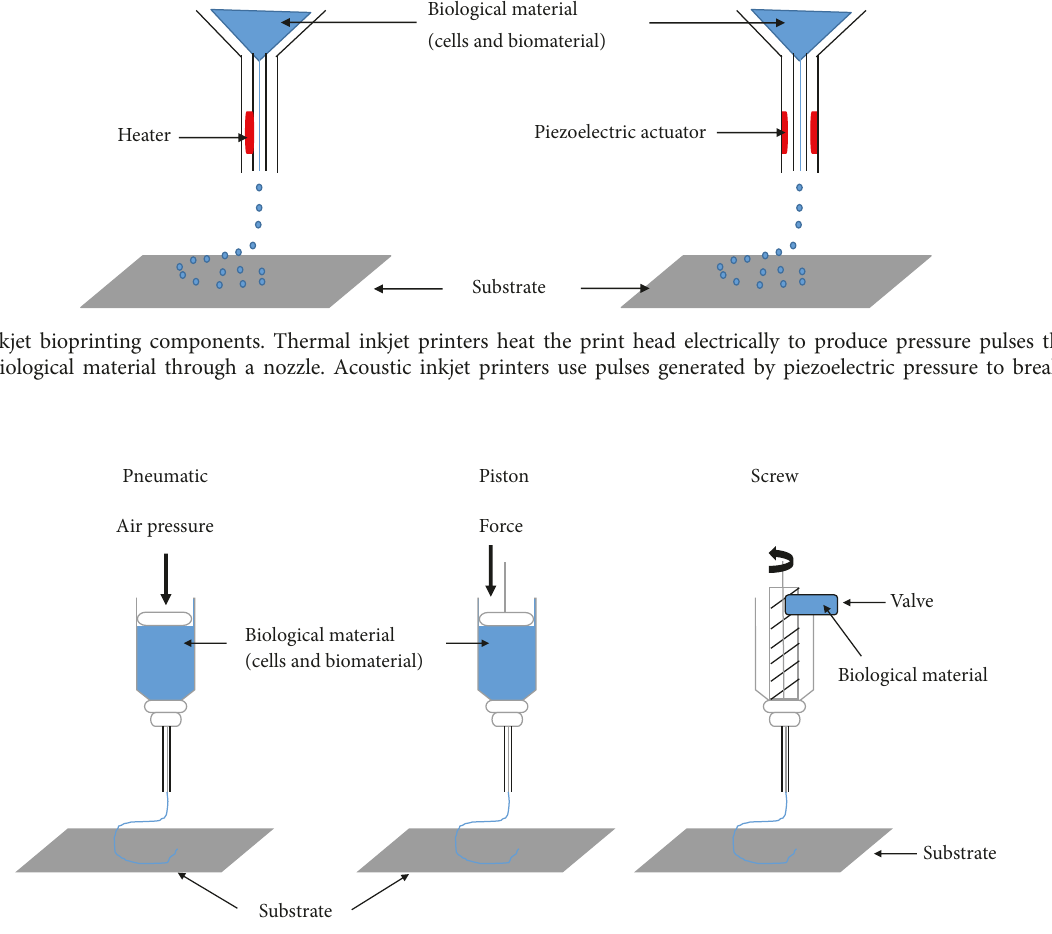
Figure 2: Pneumatic and mechanical (piston and screw) systems are used in microextrusion